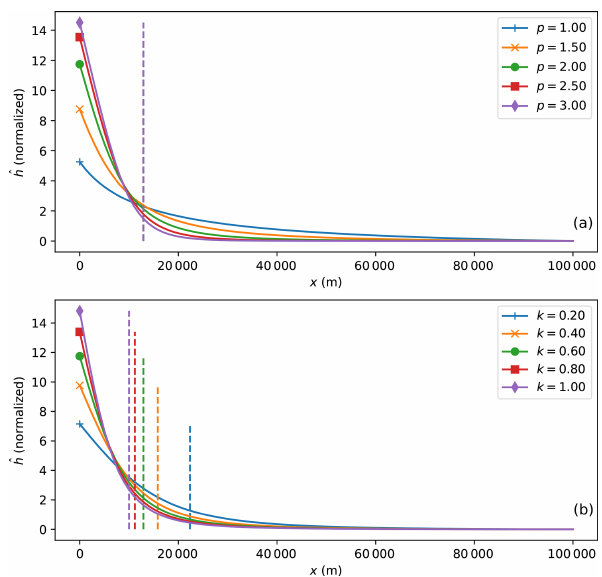
Figure 18. Effect of varying Hack’s Law ( A = kx p ) parameters ( p in a and k in b ) on the depositional system steady-state profile. The vertical dashed line represents the position of L 0 = A 0 /k 1 /p ). Because k has units that depend on p in (a) , k has been adjusted to yield the same value of L 0 for all values of p